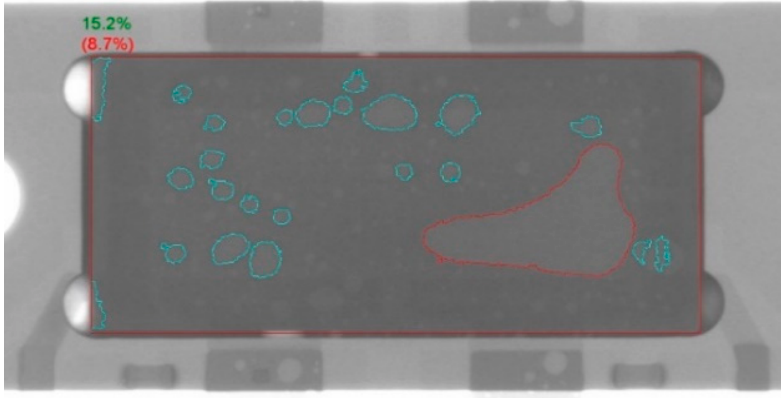
Figure 6. Example of the image of solder voids in the source electrode area of the transistor.